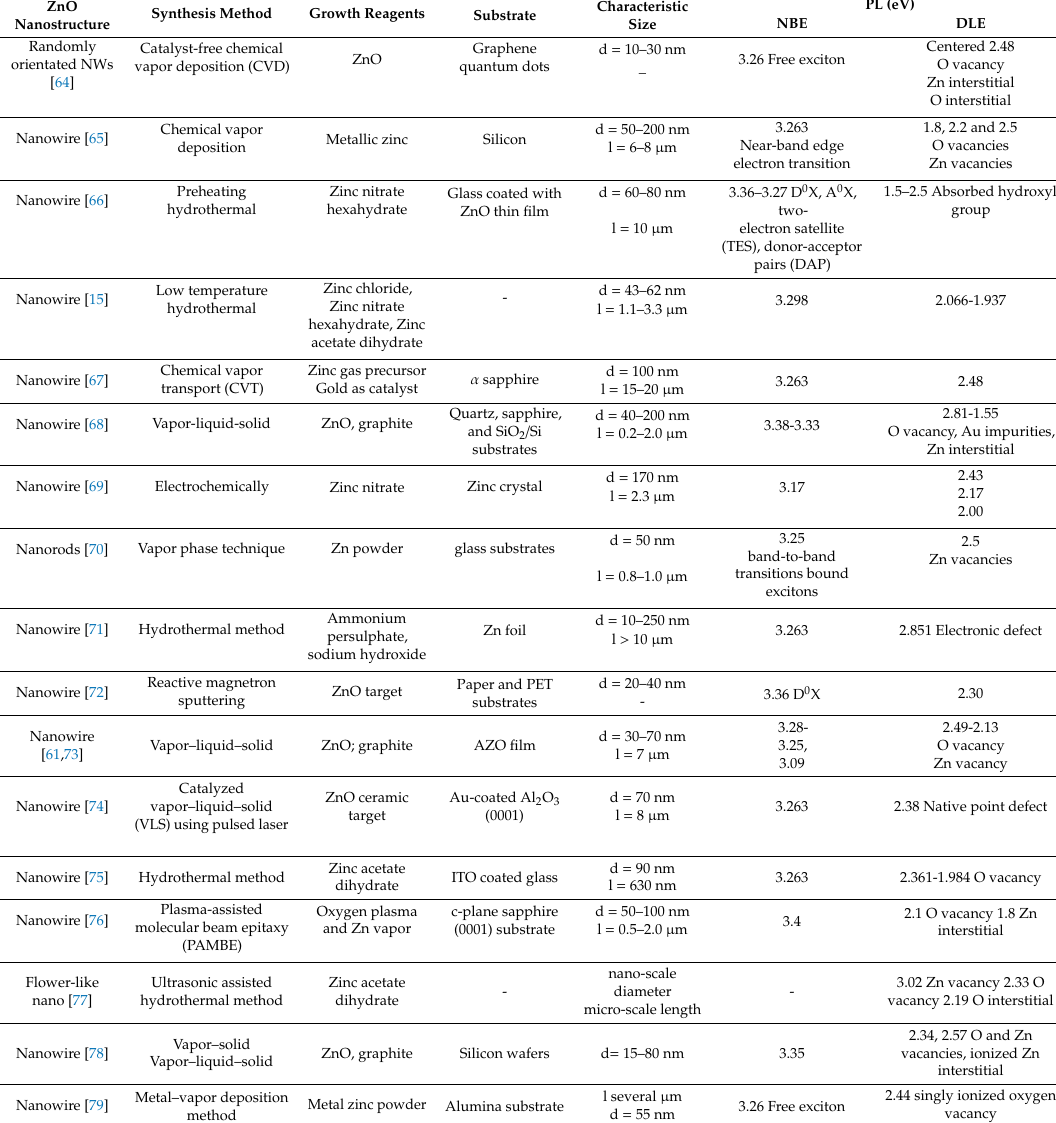
Table 1. 1DZnOnanostructures: